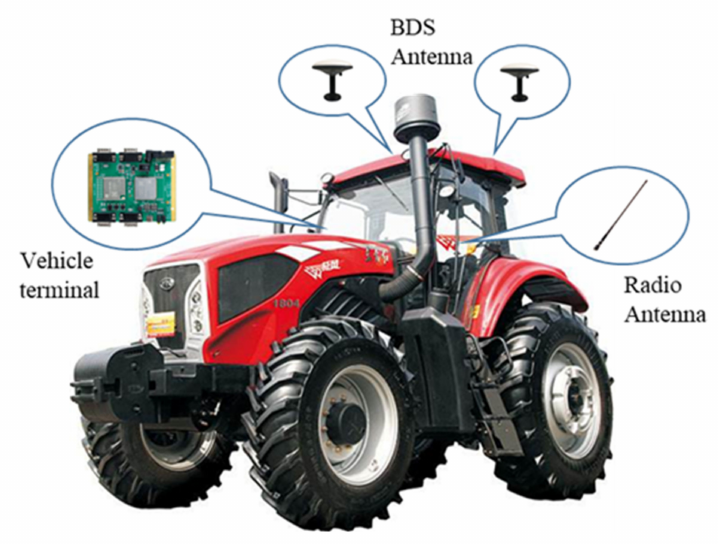
Figure 6. Vehicle-mounted mobile